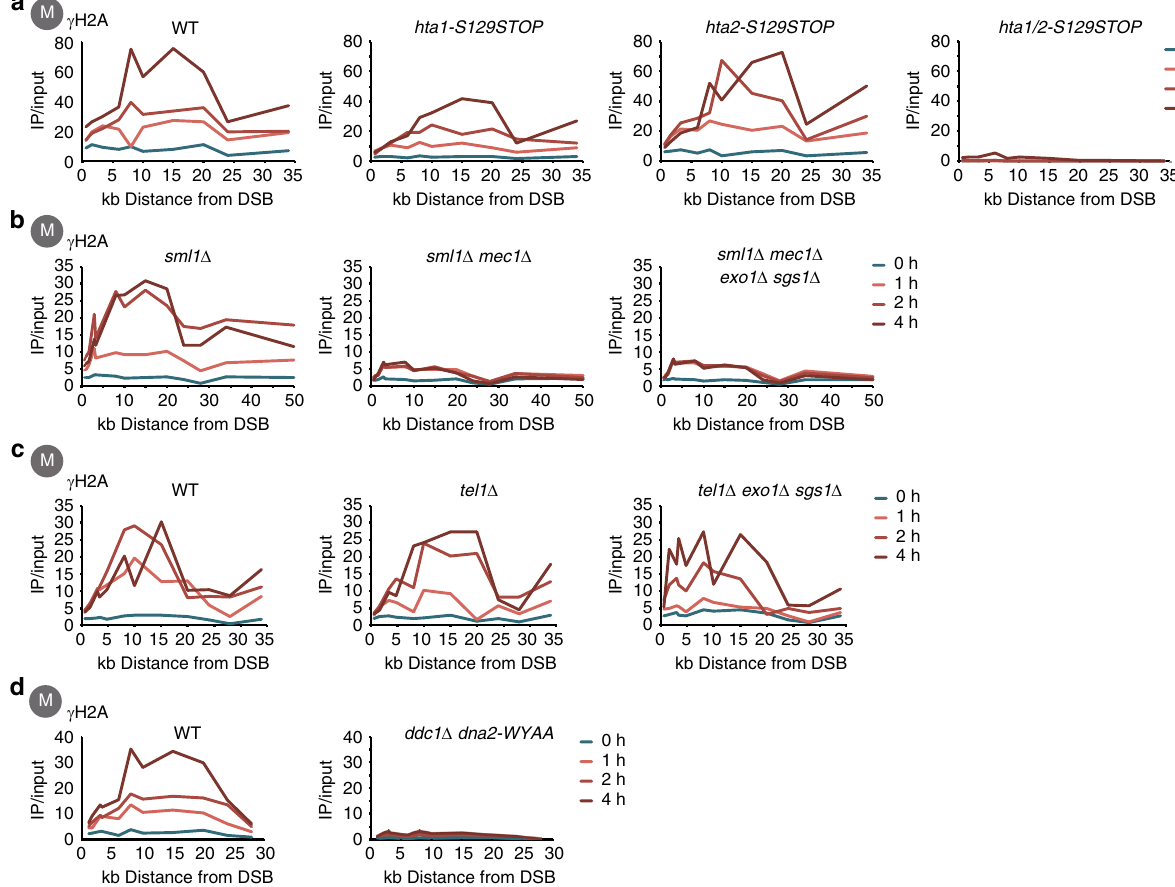
Fig. 2 γ H2A phosphorylation by Mec1 is not shaped by the H2A substrate or kinase redundancy. All data are plotted as IP/input ratios of γ H2A chromatin immunoprecipitations (ChIPs). a The number of γ H2A phosphorylation sites (H2A-S129) on chromatin is not limiting for γ H2A phosphorylation ef fi ciency. γ H2A phosphorylation was measured in strains with either normal γ H2A phosphorylation site availability (wild- type (WT)) or in strains in which the number of phosphorylation sites was reduced by mutation of either one or both H2A coding genes ( hta1-S129STOP, hta2-S129STOP , respectively). b , c γ H2A is mainly phosphorylated by Mec1 – Ddc2 in M phase. ChIP-quantitative PCR (qPCR) analysis of γ H2A phosphorylation around a double-strand break (DSB) in M phase cells. b WT, mec1 Δ sml1 Δ and mec1 Δ sml1 Δ exo1 Δ sgs1 Δ mutant strains were analysed at indicated time points. Deletion of the ribonucleotide reductase inhibitor Sml1 (suppressor of Mec1 lethality) confers viability in cells lacking Mec1 or Rad53. c WT, tel1 Δ and tel1 Δ exo1 Δ sgs1 Δ mutant strains arrested in M phase and analysed at indicated time points after DSB induction. d Mec1 activators are required for γ H2A phosphorylation. ChIP-qPCR analysis of γ H2A phosphorylation after DSB induction at MAT in WT cells and dna2-WYAA ddc1 Δ mutant cells arrested in M